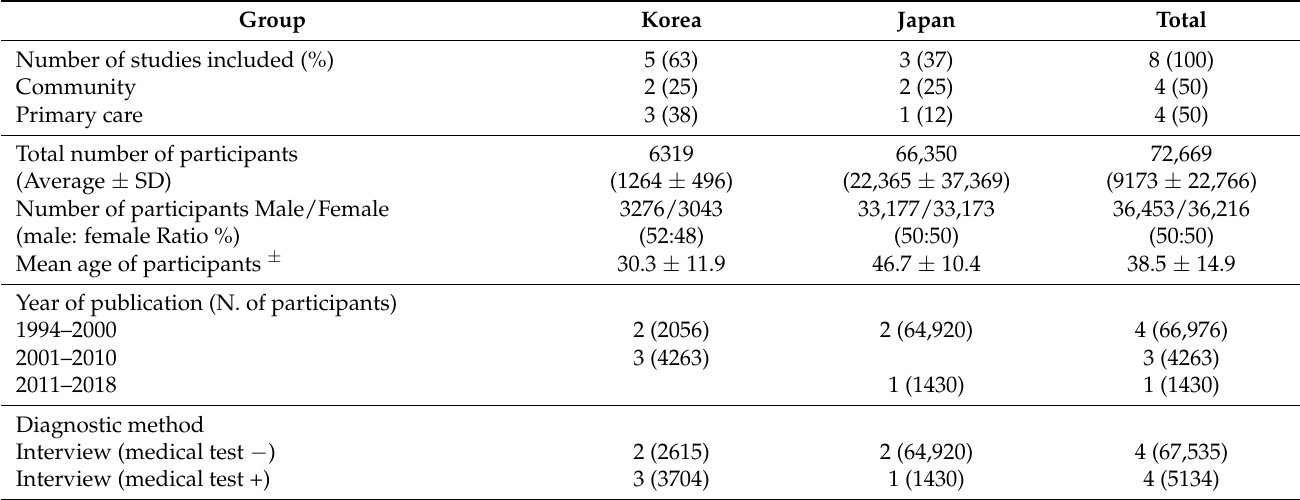
Table 1. Characteristics of the studies reporting the prevalence of ME/CFS in Korea and